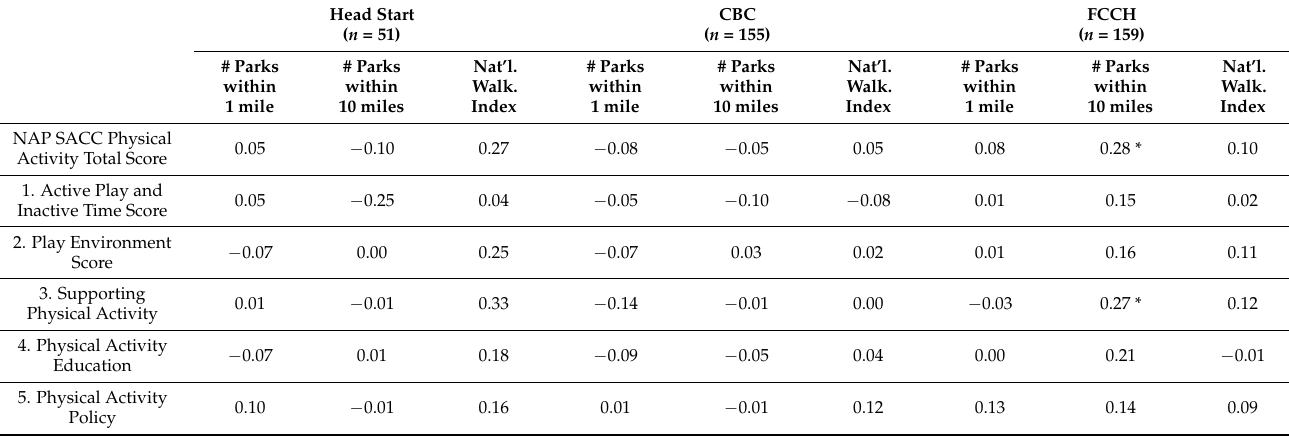
Table 3. Associations between classroom physical activity practice scores with constructs of the community physical activity environment among Oklahoma ECE programs participating in the Communities and Classroom Health Survey in 2019/2020, by childcare context.